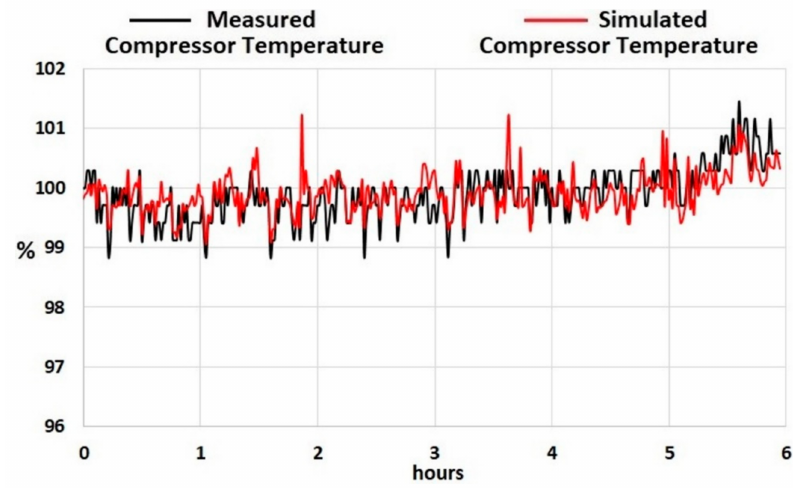
Figure 37. Measured and simulated compressor discharge temperatures at high IGV